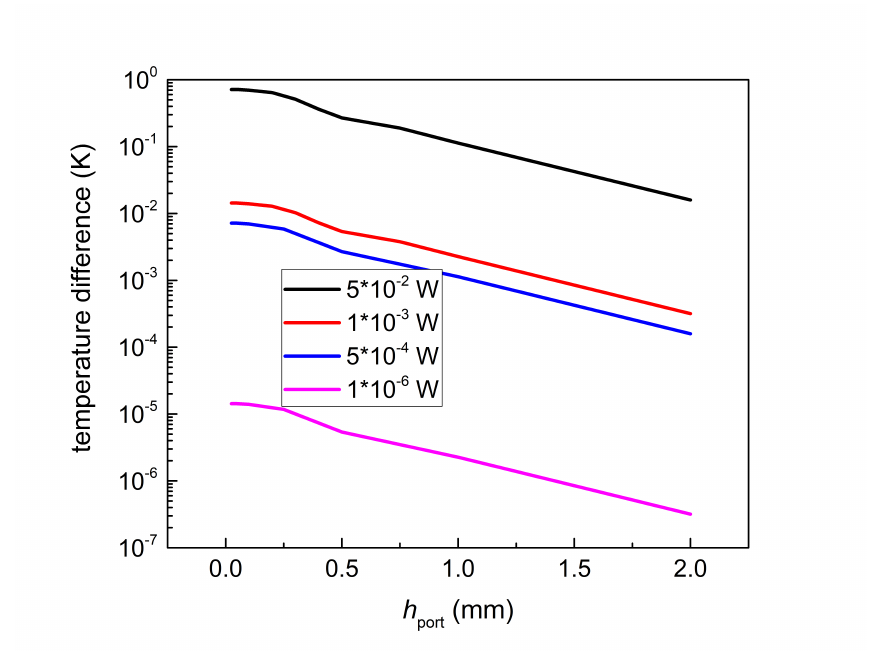
Figure 8. Temperature difference on h port at 0.3 THz; P ex values are listed in the legend.